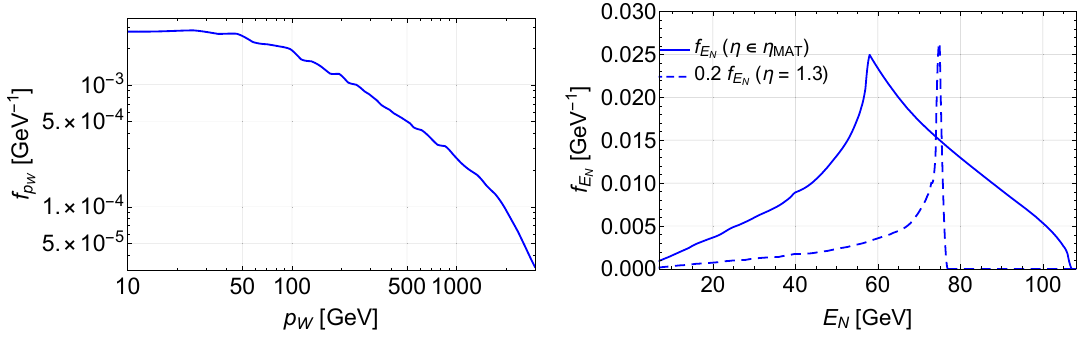
Figure 5 . Left: momentum spectrum of W bosons produced in the pp collisions at √ s = 13 TeV that is predicted by MadGraph5. Right: the energy spectrum of the HNLs produced in the decay of the W bosons and flying in the direction of the decay volume of the MATHUSLA experiment. The solid line corresponds to the spectrum obtained for the pseudorapidity range of the MATHUSLA experiment η (0 . 9 , 1 . 6), while the dashed line — to the spectrum for the HNLs flying in the ∈ direction η 1 . ≈